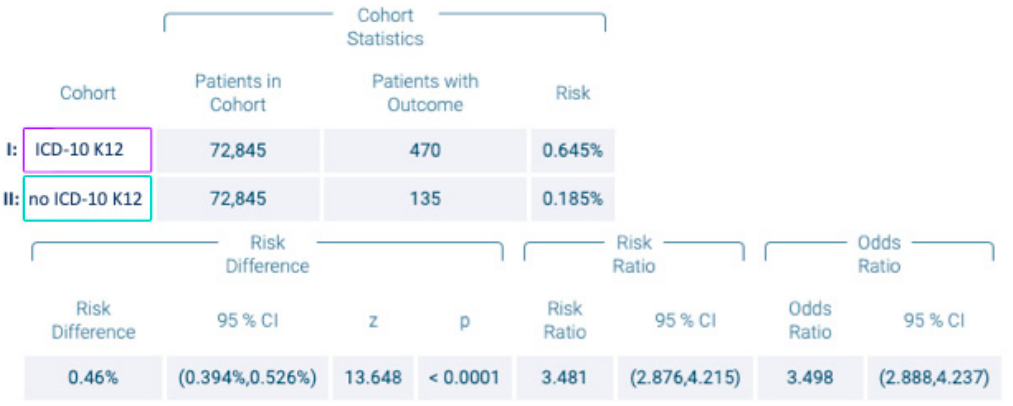
Figure 2. The Kaplan–Meier diagram is displayed in Figure 3.